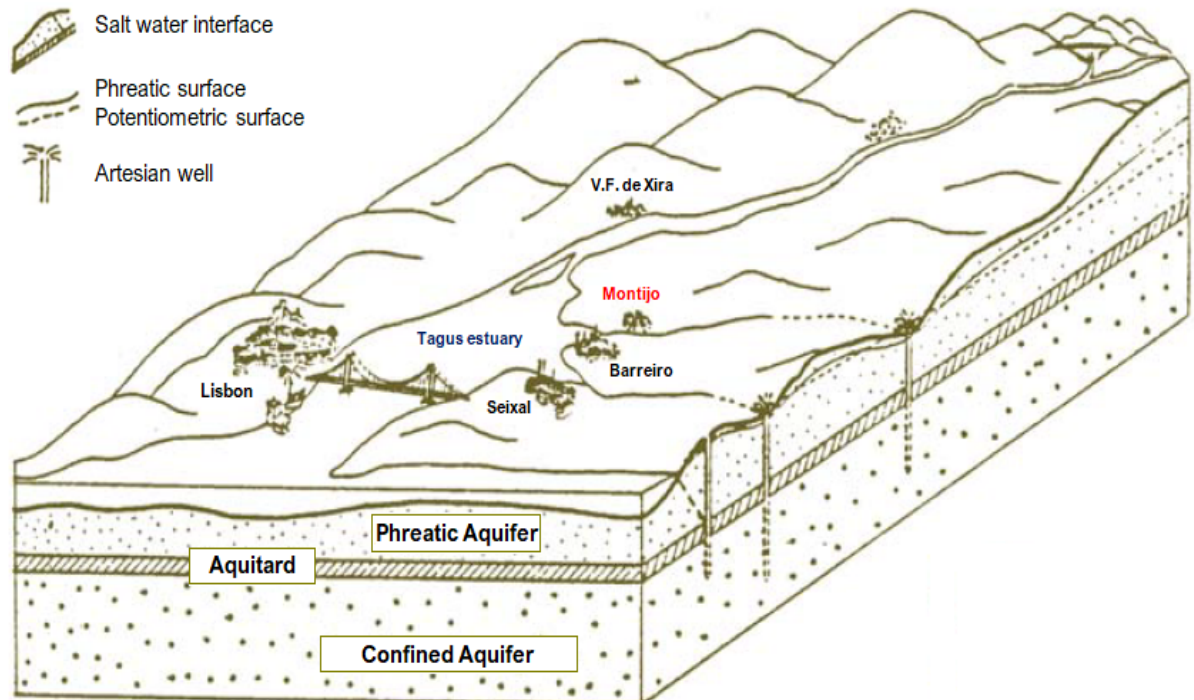
Figure 3. Schematic three-dimensional representation (conceptual model) of the Tagus-Sado Mio- Pliocene aquifer system